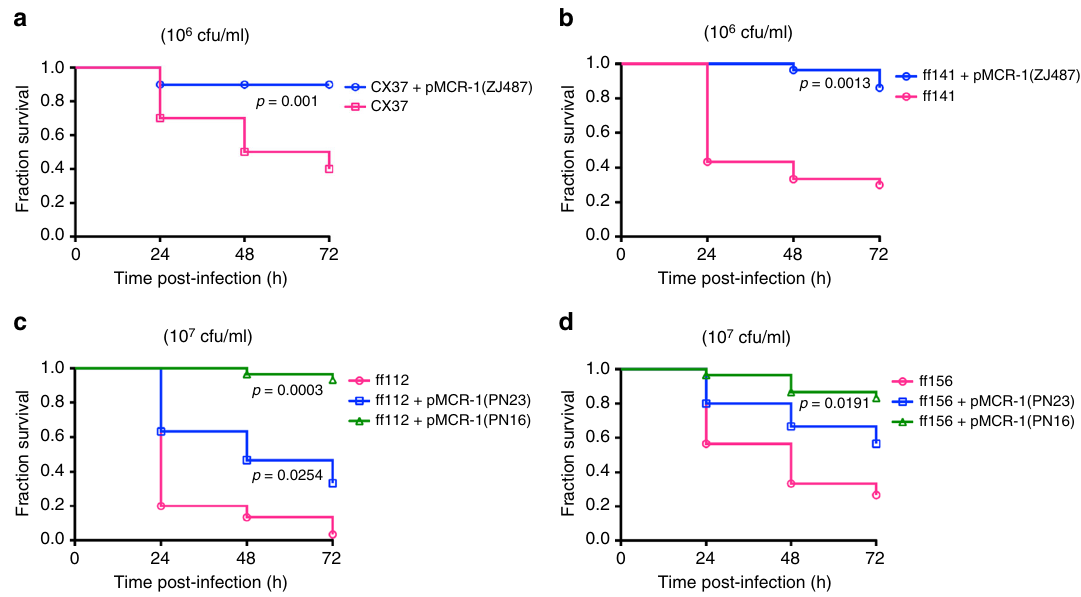
Fig. 9 Kaplan – Meier plots showing the percent survival of G. mellonella over 72 h post infection with MCRPEC and non-MCRPEC human clinical strains. Survival curves were plotted using the Kaplan – Meier method (GraphPad Software). Error bars represent the SD ( n = 3) and p value for a ( t = 8.654, d.f = 4), b ( t = 8.050, d.f = 4), c ( t = 12.07, d.f = 4 for strain ff112 with pMCR-1(PN16) and t = 3.479, d.f = 4 for strain ff112 with pMCR-1(PN23)) and d ( t = 3.801, d.f = 4) were calculated by Student ’ s t